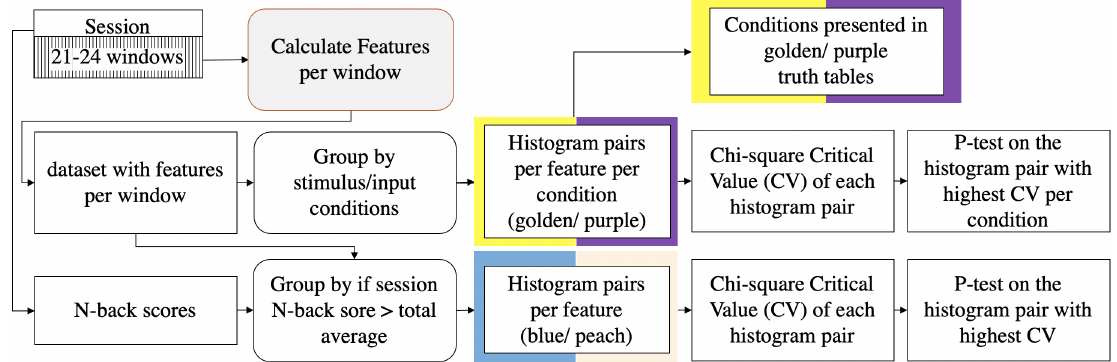
Figure 10. Flowchart of the data analysis process for Experiment 2. The ‘Calculate Features’ process is the same as the one in Experiment 1.